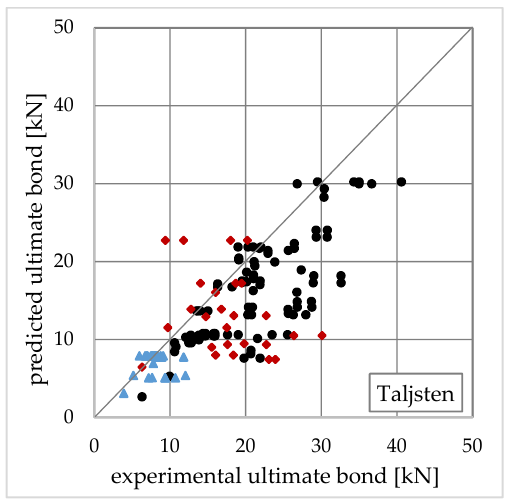
Figure 4. Test vs. predicted bond force using the Maeda et al. model [16].